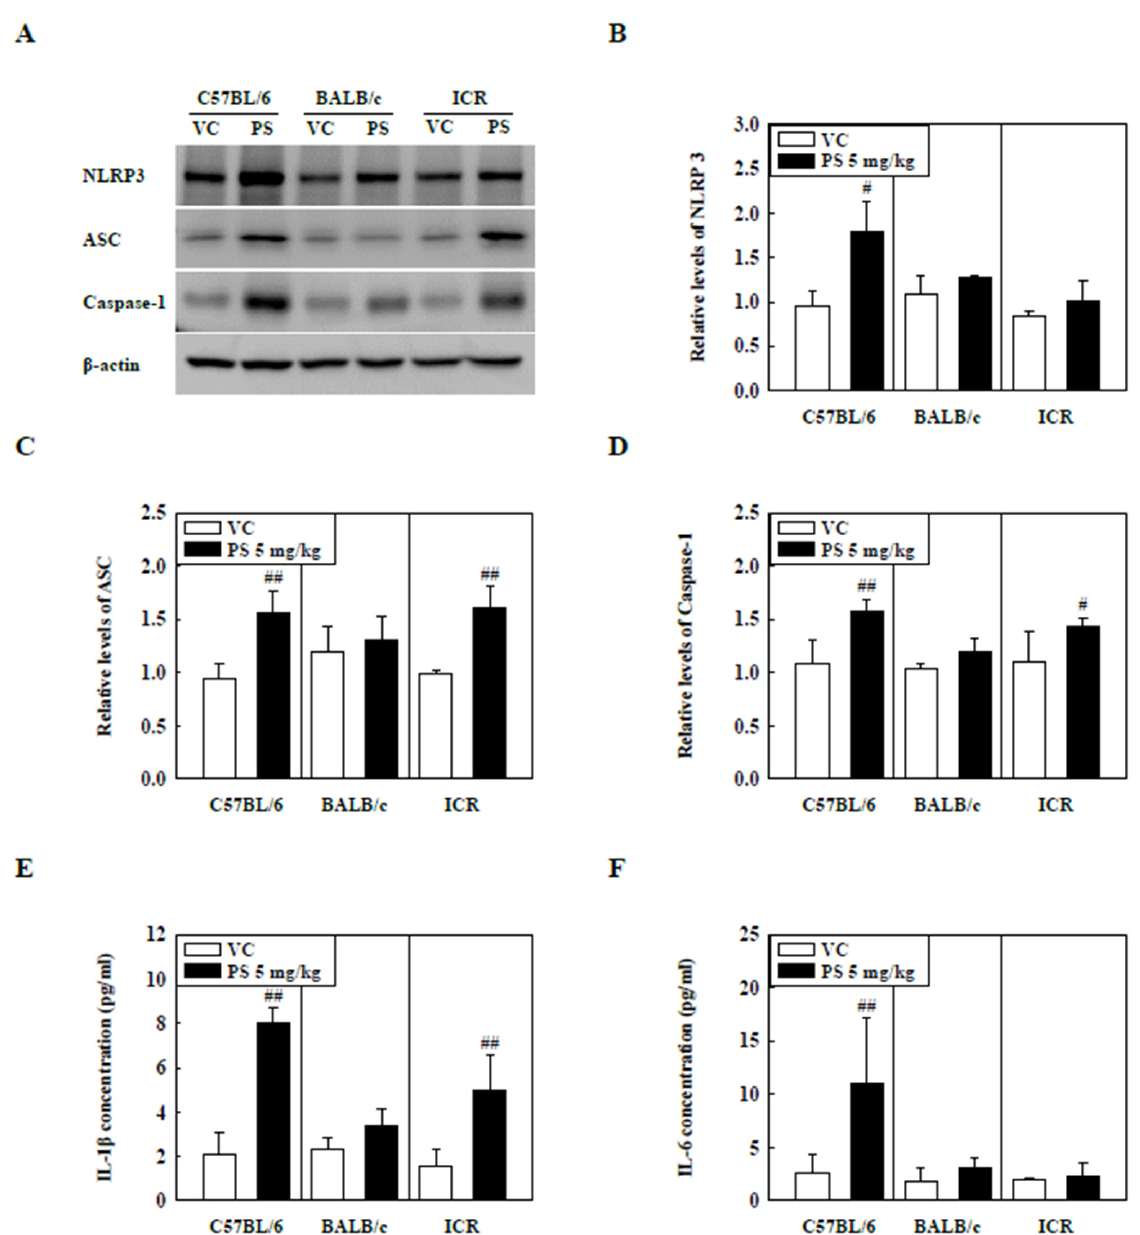
Figure 3. ( A ) Representative Western blot images of NLRP3, ASC, and Caspase-1 expression in lung tissue of three strains of PS-instilled mice. ( B ) Relative density analysis of NLRP3 levels. ( C ) Relative density analysis of ASC levels. ( D ) Relative density analysis of Caspase-1 levels. Data were normalized against β -actin. Inflammatory cytokine levels, including ( E ) IL-1 β and ( F ) IL-6, in the BALF of three strains of PS-instilled mice. Data are represented as mean ± SD (n = 5 per group). # p ≤ 0.05; ## p ≤ 0.01 vs. VC.